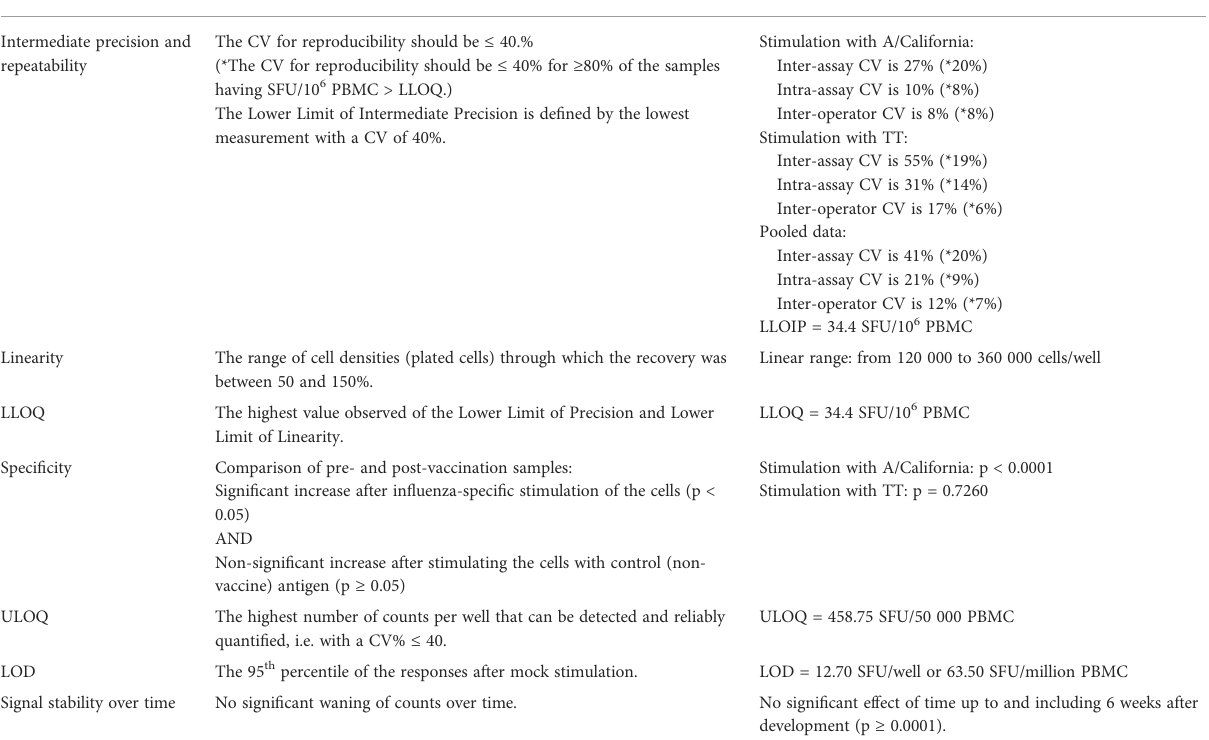
TABLE 3 Assay quali fi cation summary. Assay parameter Acceptance criteria Quali fi cation outcome Intermediate precision and